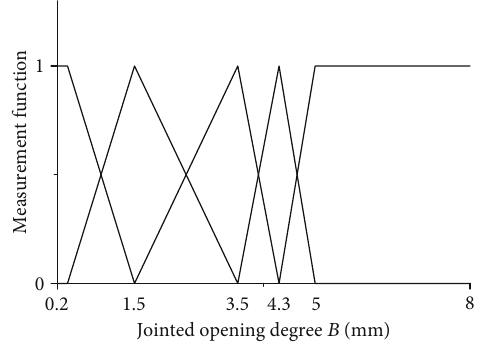
Figure 9: Uncertainty measurement function of jointed opening degree.